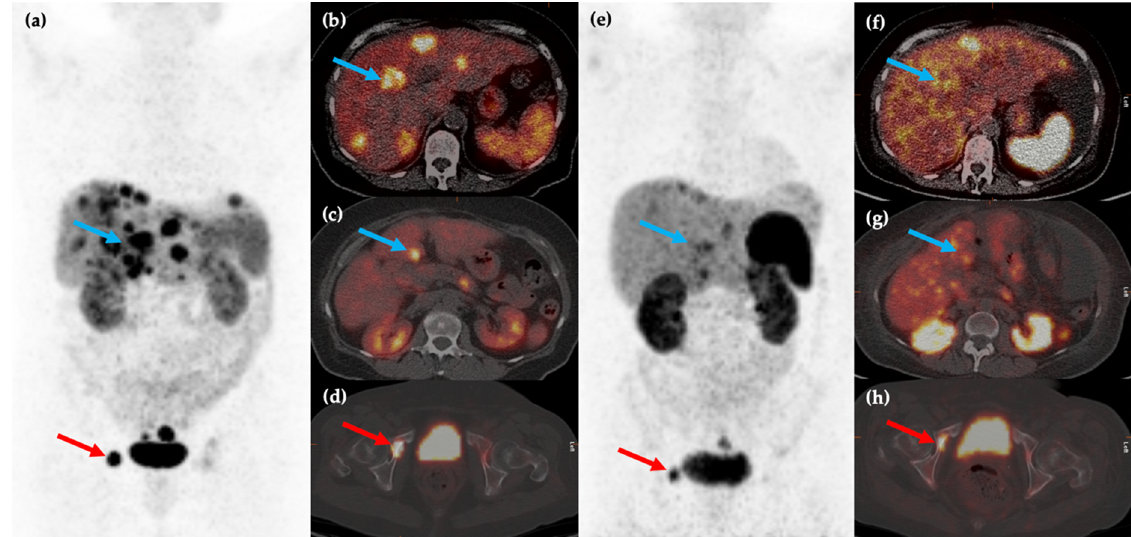
Figure 3. Fifty-year-old female with metastatic G1 NET to liver and bones. 68 Ga-DOTATATE PET/CT MIP ( a ) and axial ( b – d ) images show multiple sites of SSTR positive hepatic (blue arrows) and osseous (red arrows) disease. The patient was treated with 177 Lu-DOTATATE with favorable partial response on post-therapy 68 Ga-DOTATATE PET/CT MIP ( e ) and axial ( f – h ) images, which show reduction in size and/or number of the previous sites of disease.